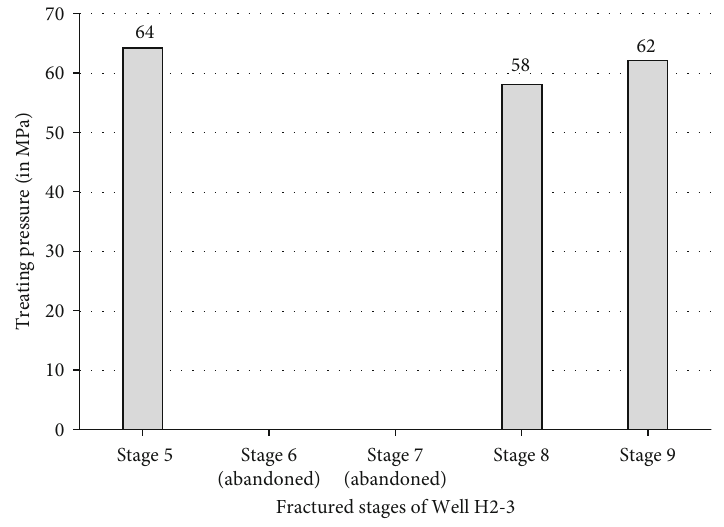
Figure 16: The treating pressure of stages 5, 6, 7, 8, and 9 in Well H2-3.